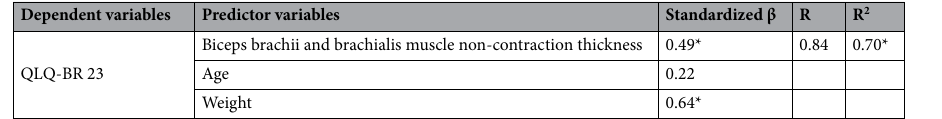
Table 4. Multiple regression analysis about the Quality of Life Questionnaire Breast Cancer (QLQ-BR 23). QLQ-BR, Quality of Life Questionnaire Breast Cancer. *p <